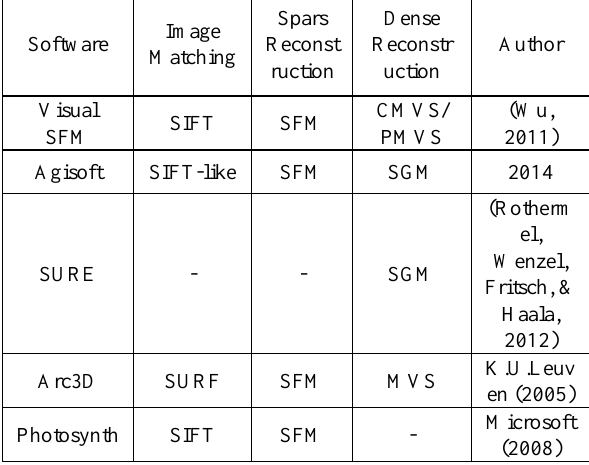
Table 1 - Used Software in recent studies Preparing a three-dimensional model of an object depends